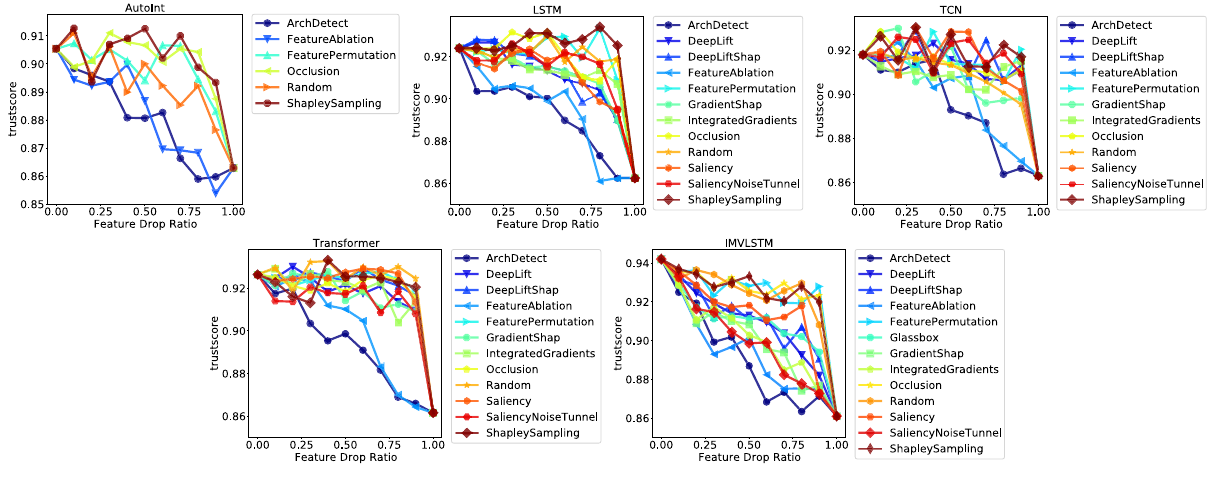
Figure 4. Curves of trustworthiness metric w.r.t feature drop